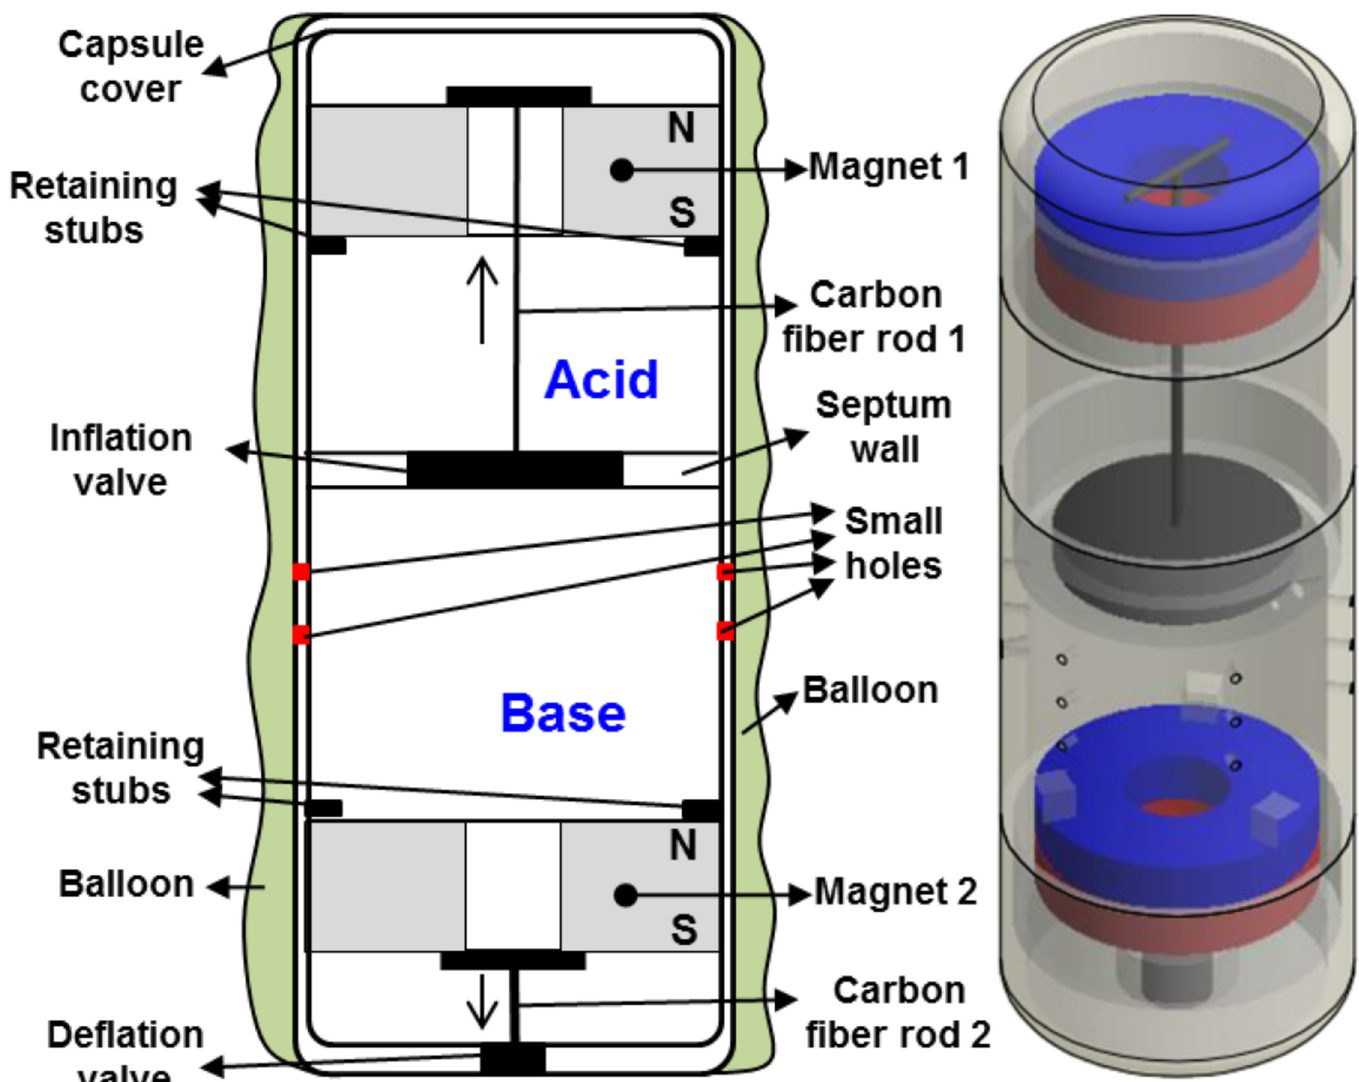
Fig 5. Structure of the proposed